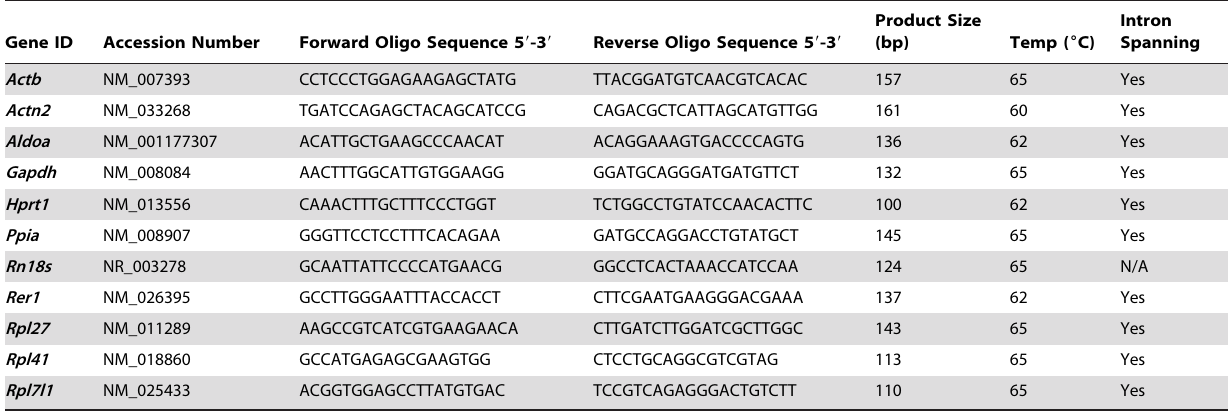
Table 2. RT-qPCR primers.